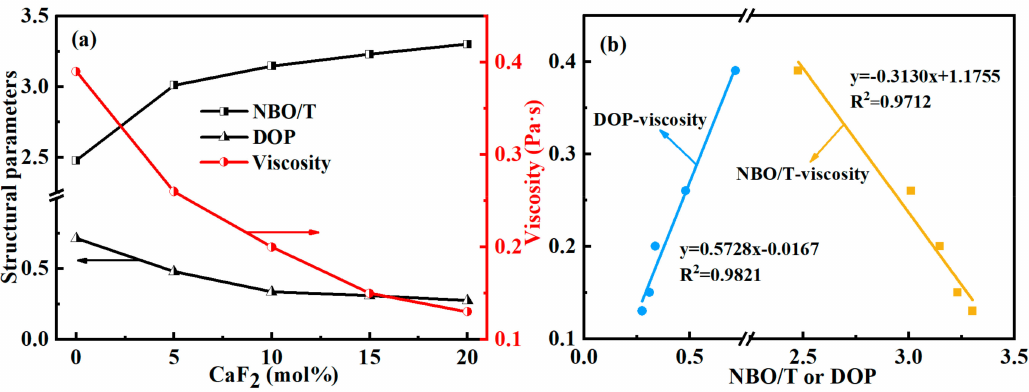
Figure 7. ( a ) Change of structural parameters and viscosity and ( b ) the relationship between viscosity and structural